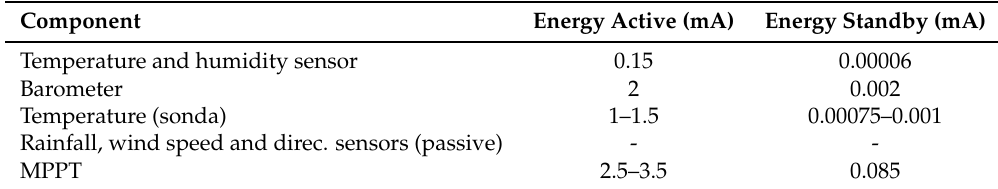
Table 5. Sensors energy consumption.